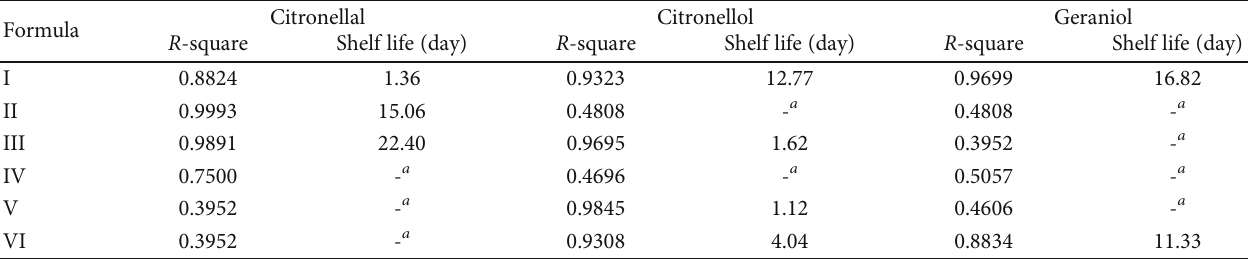
Table 3: Controlled release of citronellal, citronellol, and geraniol from air freshener gel formulations. Formula